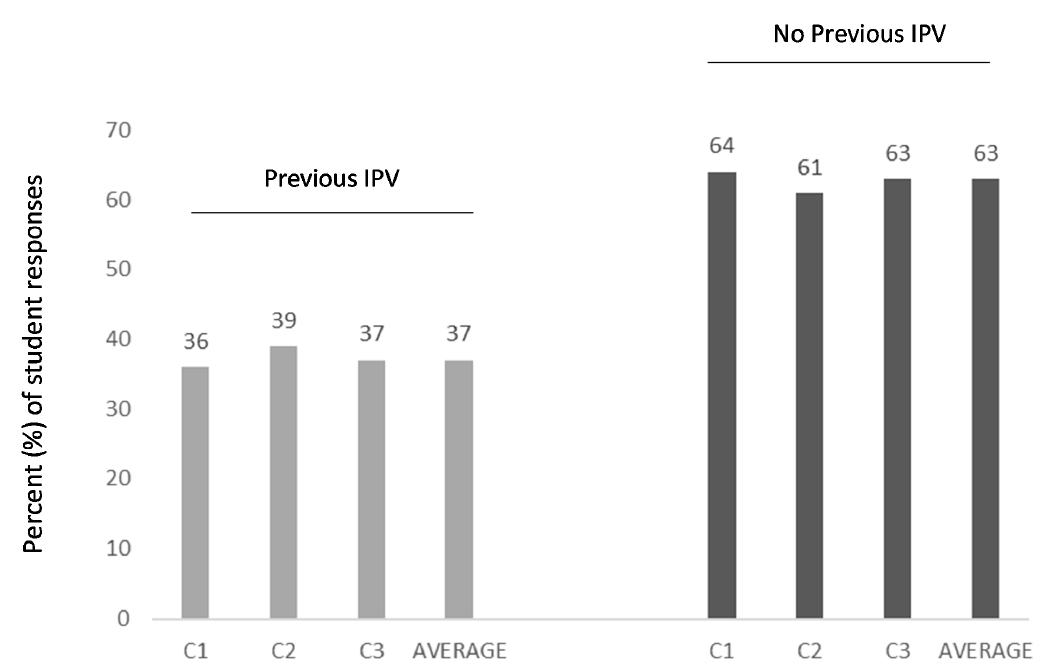
Figure 1. Previous IPV education among respondents. Approximately two-thirds (64%) of respondents indicated that they had no formal educational experience with either IPV or DV in a curricular setting or educational environment, with no significant changes over time during the time period evaluated by this study, p = 0.411. In addition, slight differences between males and females were noted, with a slightly higher percentages of males (71.1%) reporting no previous IPV or DV experience than their overall percentage in the school population (62.4%), which was not statistically significant, p =